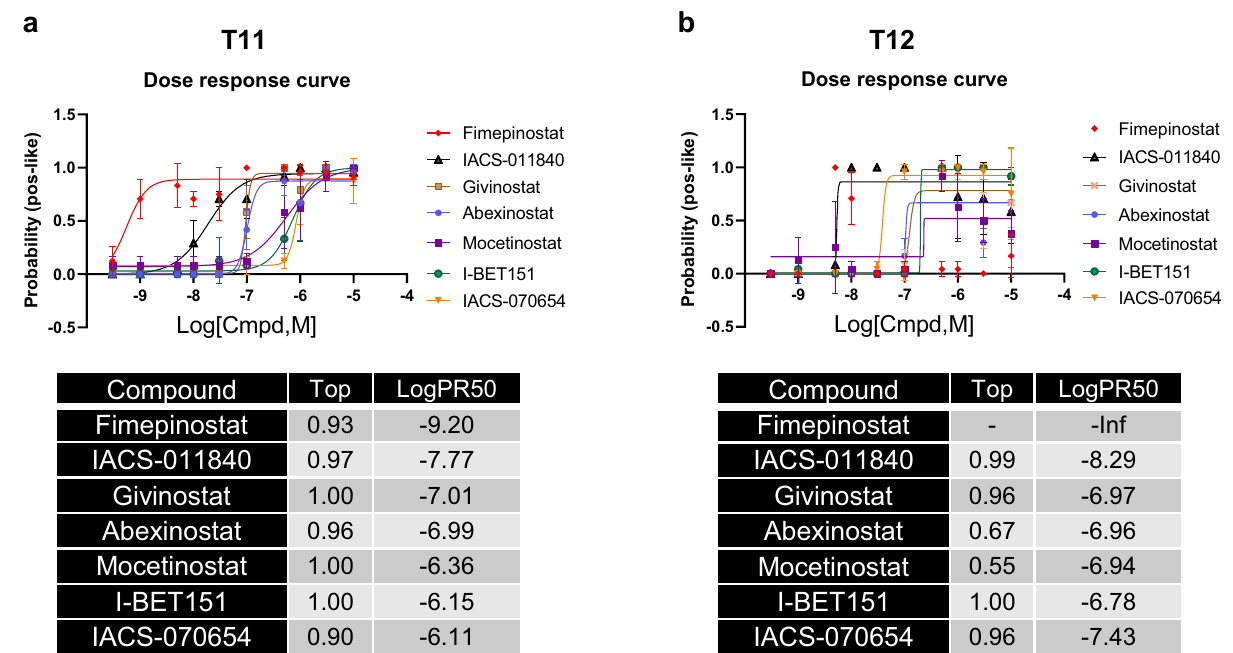
Fig. 4 Dose curve responses of the top drug hits. Dose – response curves of the probability resembling the positive control by concentration for T11 ( a ) and T12 ( b ) organoids. Data points represent the mean and standard deviation of four technical replicates. Curves are fi t using a constrained 4-parameter logistic using Graphpad Prism. The resulting curve fi t parameters describing ef fi cacy (top probability score) and potency (LogPR50 concentration) are summarized in the lower